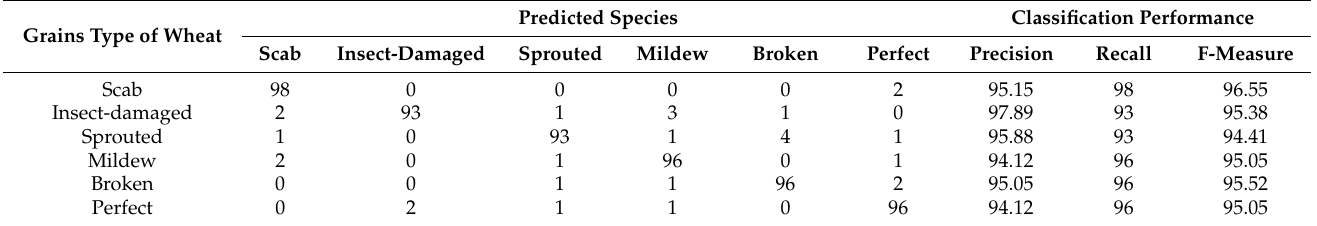
Table 3. Confusion matrix and classification performance of the ResNet-50 model.